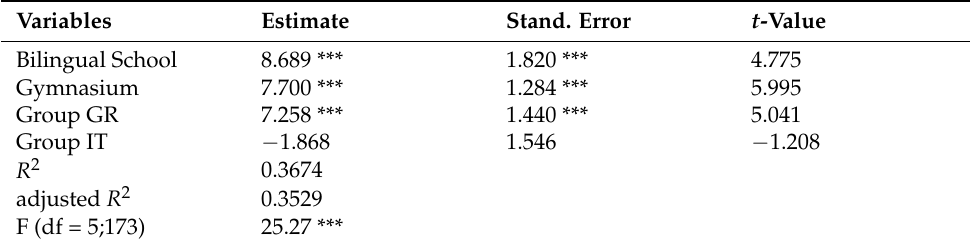
Table A1. Effects of school type and language group on LAT scores in L1.